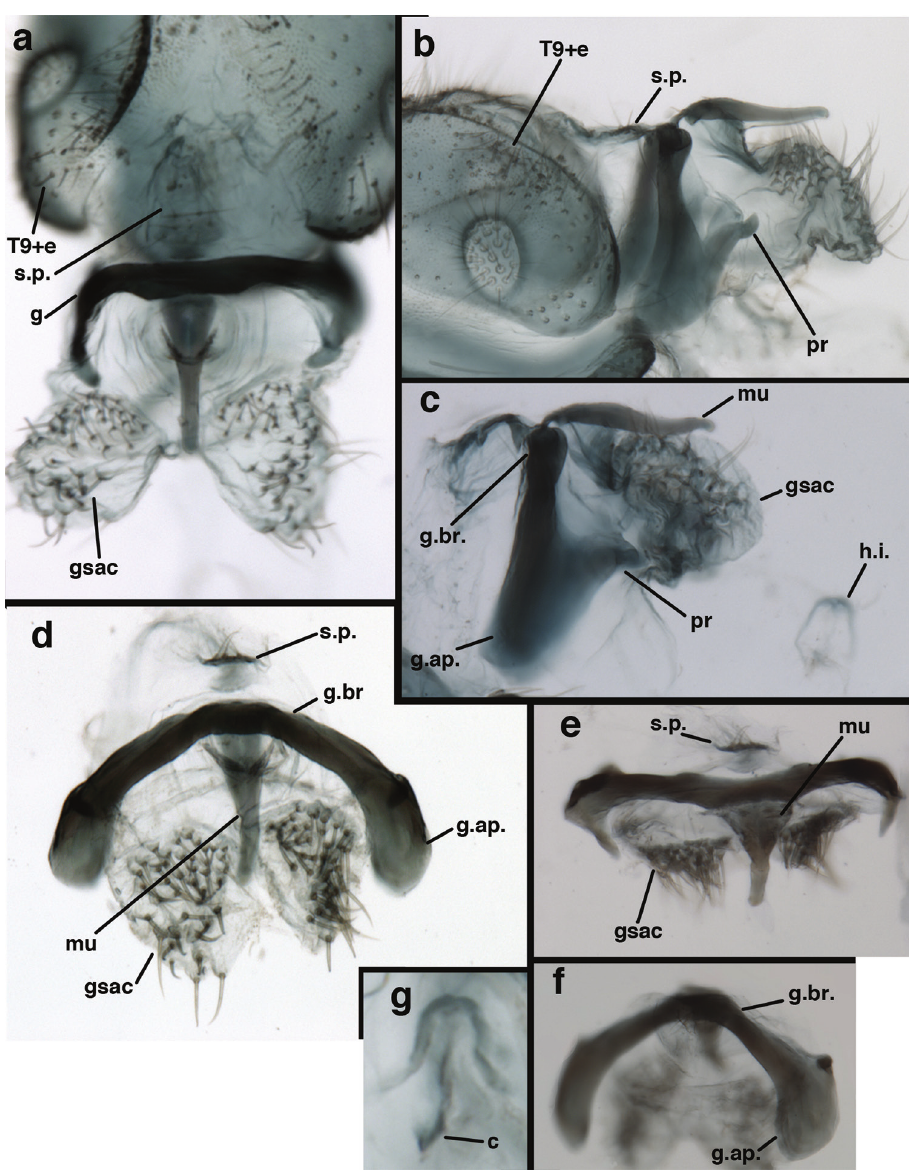
Figure 106. Ungla argentina (Navás): Male genitalia, ( a ) gonarcus, frontodorsal, attached dorsally to abdominal terminus via very short membrane ( b ) gonarcus, membranous attachment to T9+ectoproct, lateral ( c ) gonarcus, lateral, with hypandrium internum, frontal ( d ) gonarcus, frontodorsal ( e ) gonarcus, dorsal ( f ) gonarcus, posterior ( g ) hypandrium internum, frontal. c comes g gonarcus g.ap. gonarcal apodeme g.br. gonarcal bridge gsac gonosaccus h.i. hypandrium internum mu mediuncus pr unar- ticulated process on frontal margin of apodeme s.p. setose subanal plate T9+e fused ninth tergite and ectoproct (Argentina; a, b, g Tucumán, CAS; c Catamarca, CAS; d, e, f Santiago del Estero,